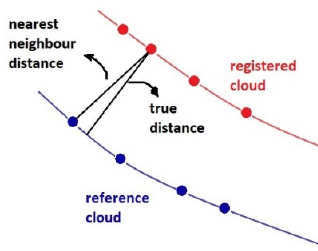
Figure 9. Calculating the distance between the point clouds using k -nearest neighbour.